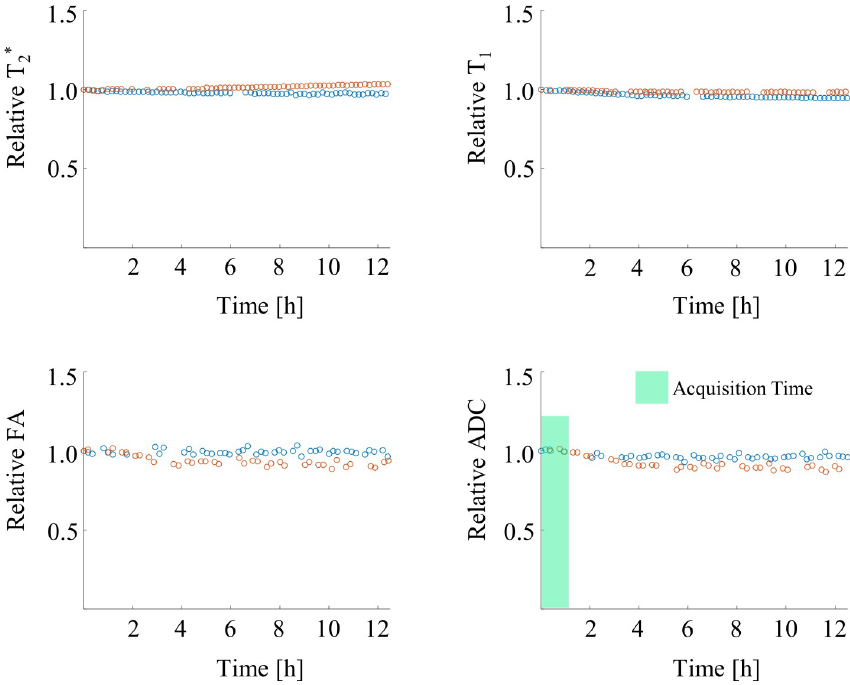
Fig 3. Temporal evolution of sample stability using measures of T2 � , T 1 , FA, and ADC. Values are plotted relative to time point t = 0 over a period of 12 hours for two hearts (blue, red). Changes in myocardial T 2 � and T 1 over this time period for the two hearts were 2–5% and 2–6%, respectively. Mean ± single standard deviation were 0.45 ± 0.01 and 0.45 ± 0.02 for FA and 0.63 ± 0.02 [10 − 3 mm 2 /s] and 0.69 ± 0.03 [10 − 3 mm 2 /s] for ADC respectively. The green area marks the time interval, were the diffusion measurements at 7T would take place. Derived diffusion parameters measured within this time interval were stable.